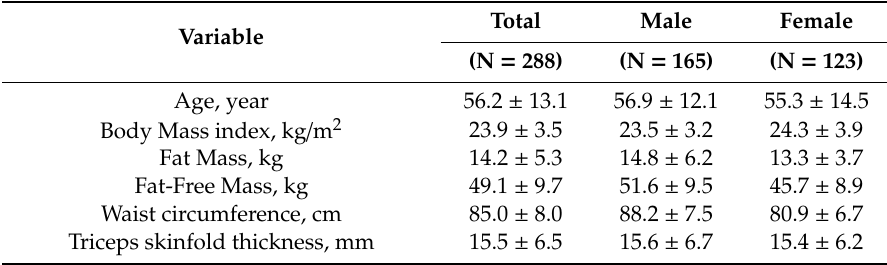
Table 1. Baseline characteristics of all